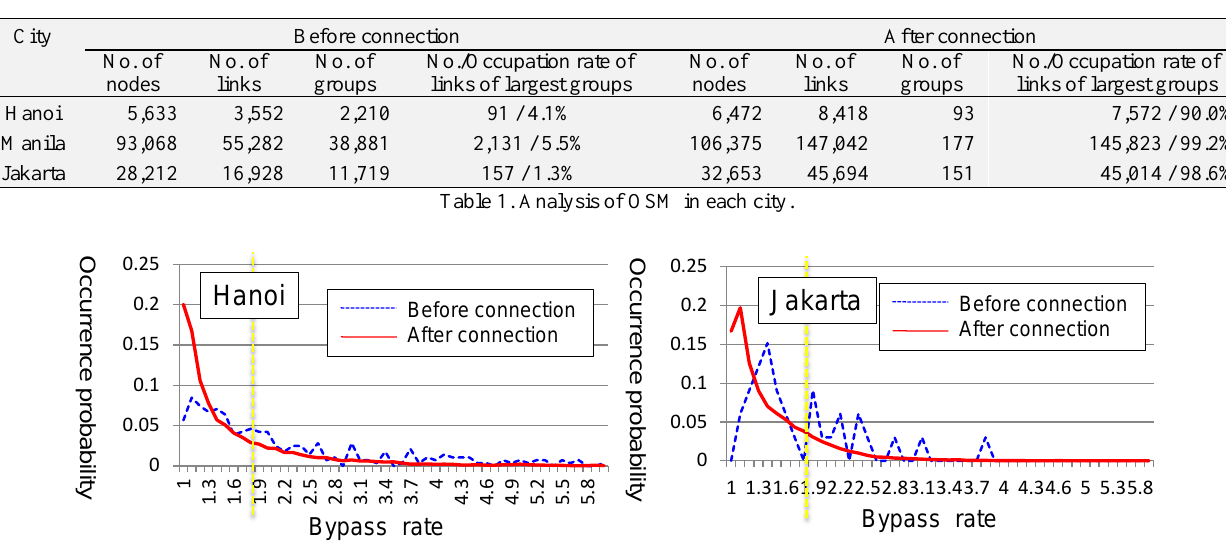
Figure 5. Comparison of bypass rate before/after connection in OSM of three